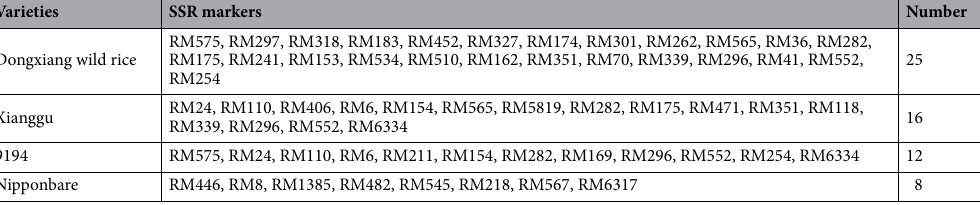
Table 4. Polymorphic primers for the genetic integrity in different